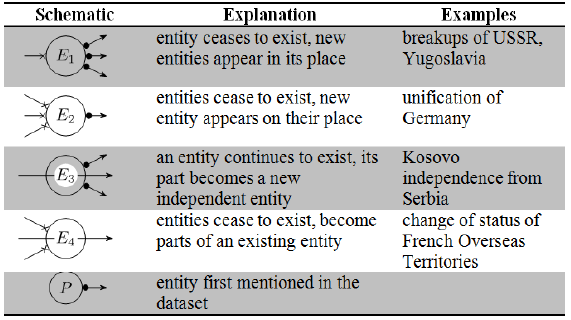
Figure 2. Existential transformation of world entities